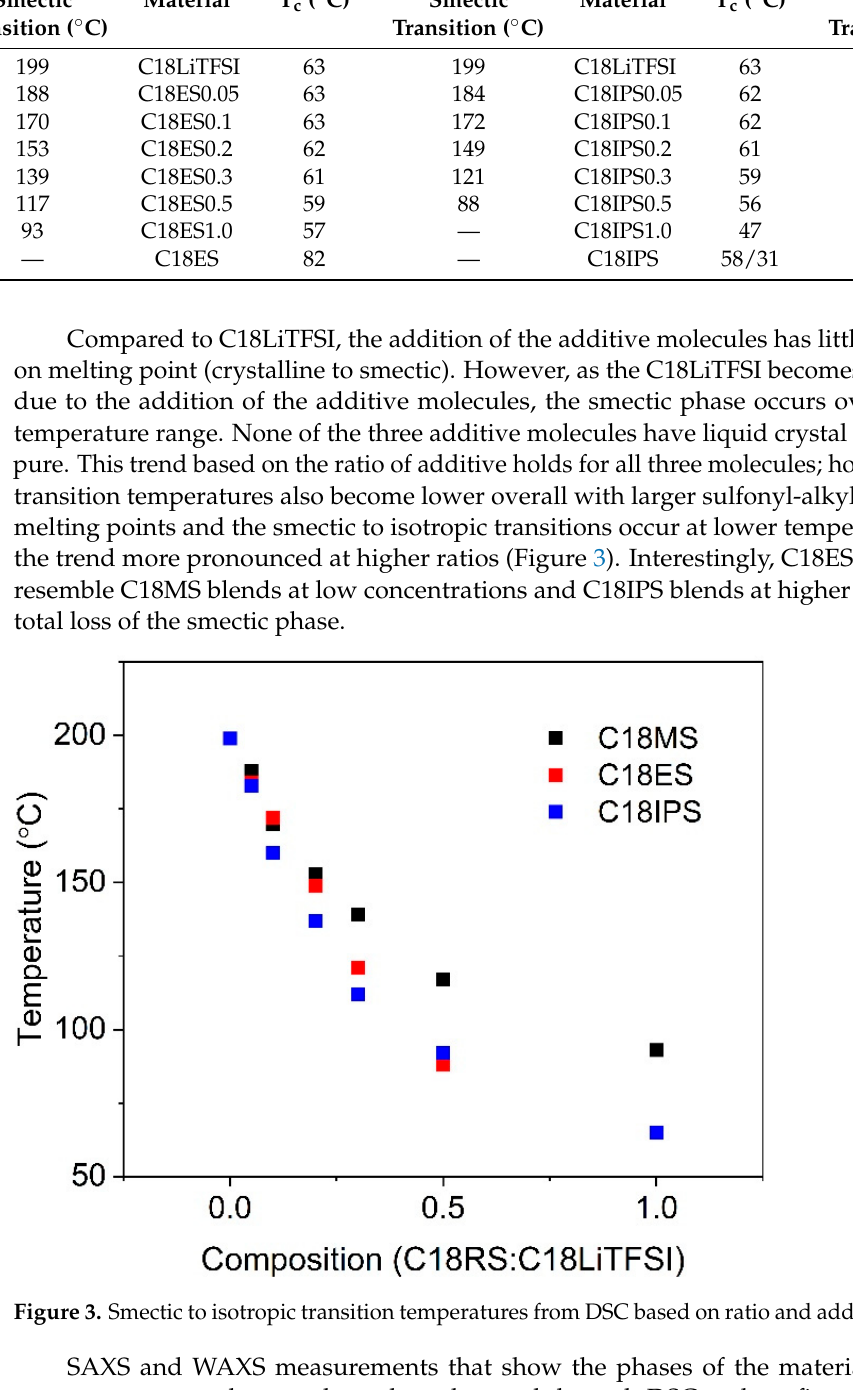
Figure 3. Smectic to isotropic transition temperatures from DSC based on ratio and additive molecule. SAXS and WAXS measurements that show the phases of the material at various temperatures corroborate phase data observed through DSC and confirm the